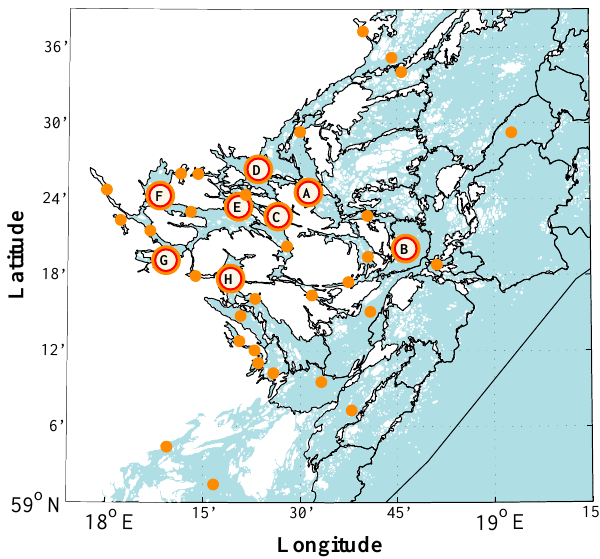
Figure 4. Available locations with observations (circles and dots) in the Stockholm Archipelago. Model evaluation of temperature, salinity, DIN, DIP and bottom water oxygen concentration was per- formed at selected stations (circles marked with letters), which are described in Table 1.